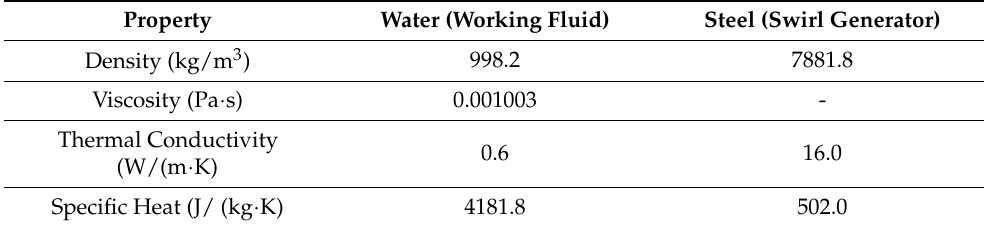
Table 2. The thermophysical characteristics of considered materials.